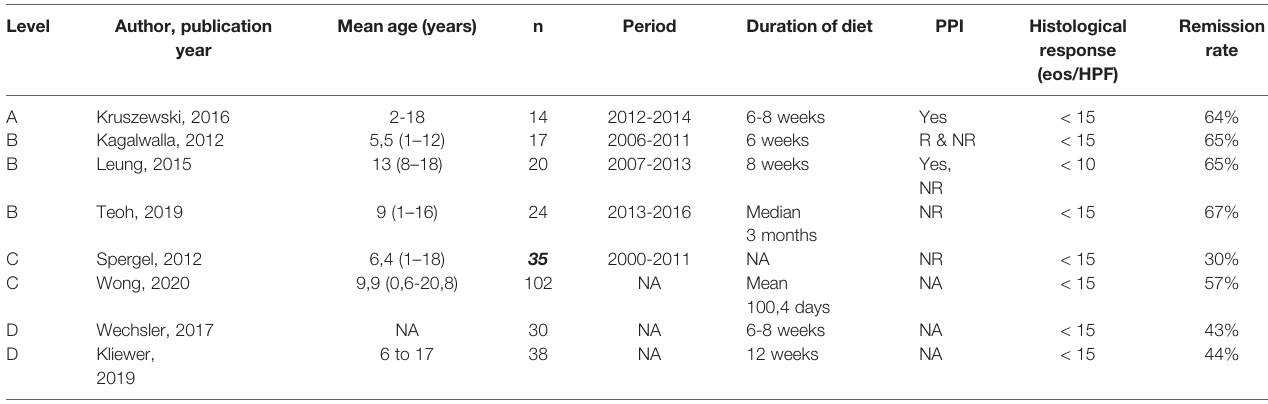
TABLE 7 | Overview of studies on the cow ’ s milk elimination diet.